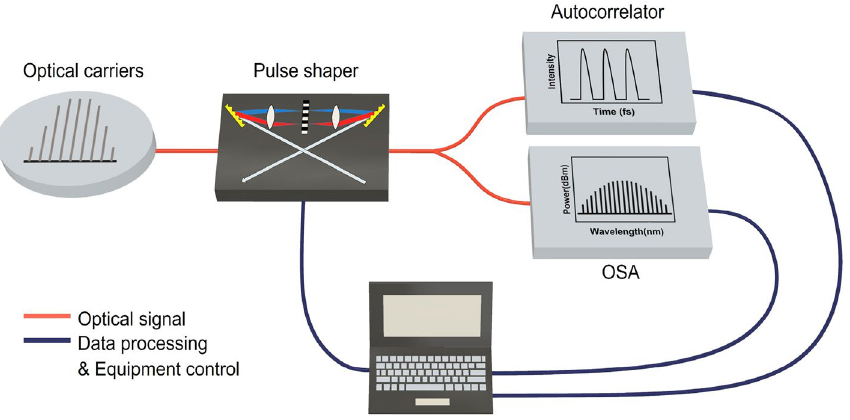
Figure 2. Schematic of programmable pulse phase and amplitude shaping. OSA optical spectrum